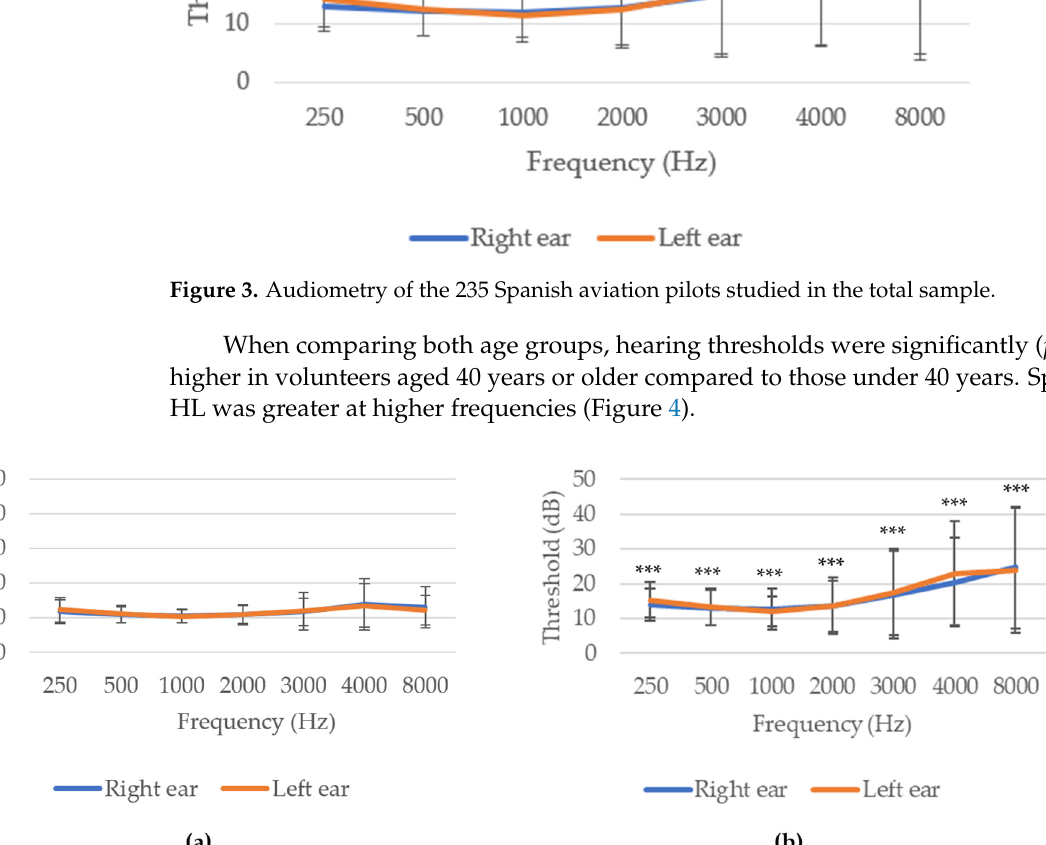
Figure 4. Audiometry of the sample sorted by age groups: ( a ) <40 years old; ( b ) ≥ 40 years old. * p ≤